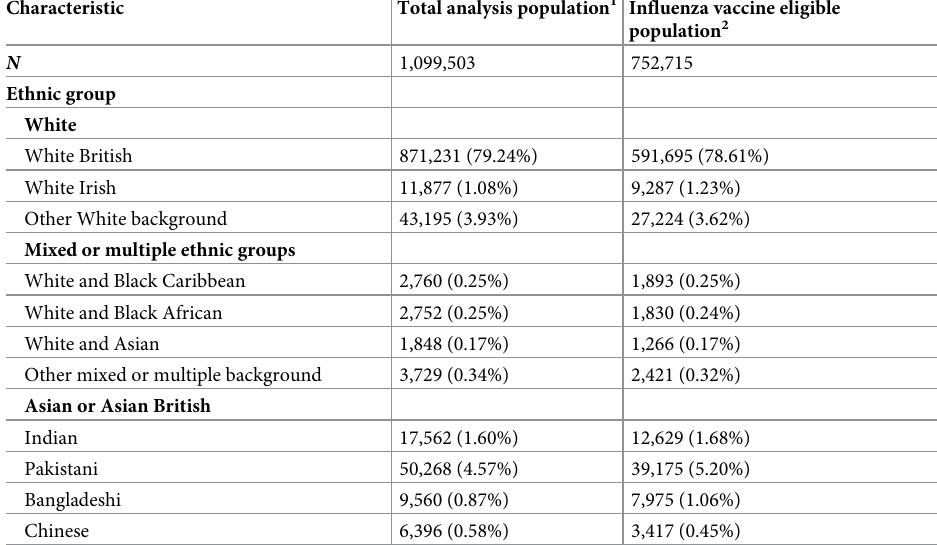
Table 1. Baseline characteristics and vaccine